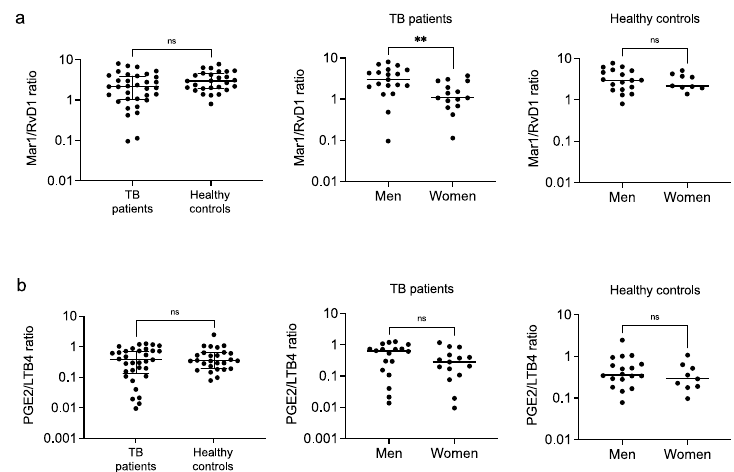
Figure 5. Pro-resolutory and pro-inflammatory ratios of circulating eicosanoids. Pro-resolutory Mar1/RvD1 ( a ), and pro-inflammatory PGE2/LTB4 ( b ) ratios were calculated from the serum levels of eicosanoids of patients with pulmonary tuberculosis and healthy controls. Individual results with medians and interquartile ranges are depicted ( left ). Data were disaggregated by sex for both the patients ( center ) and controls ( right ); individual results with medians are depicted. ** p < 0.01, ns = not significant.